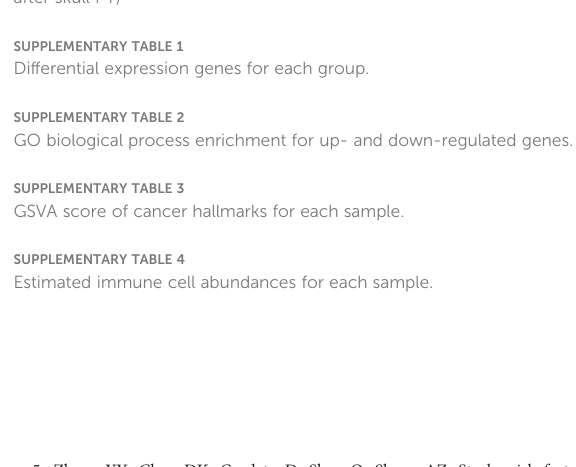
SUPPLEMENTARY FIGURE 1 The batch effect removal of RNA-seq data. (BC: control group for uninjured brain; B2B and B6B: brain samples group for the 2 nd or 6 th day after brain PT; SC:controlgroupforuninjuredskull;S2SandS4S:skullsamplesgroupforthe 2 nd or4 th dayafterskullPT;B2SandB6S:skullsamplesgroupforthe2 nd or6 th day after brain PT; S2B and S4B: brain samples group for the 2 nd or 4 th day after skull PT) SUPPLEMENTARY FIGURE 2 Volcano plot of DEGs for the brain and skull ischemic injury (up-regulated in purple, down-regulatedin green). (BC: control groupforuninjuredbrain;B2B andB6B:brainsamplesgroupforthe2 nd or6 th dayafterbrainPT;SC:control group for uninjured skull; S2S and S4S: skull samples group for the 2 nd or 4 th dayafterskullPT;B2SandB6S:skullsamplesgroupforthe2 nd or6 th dayafter